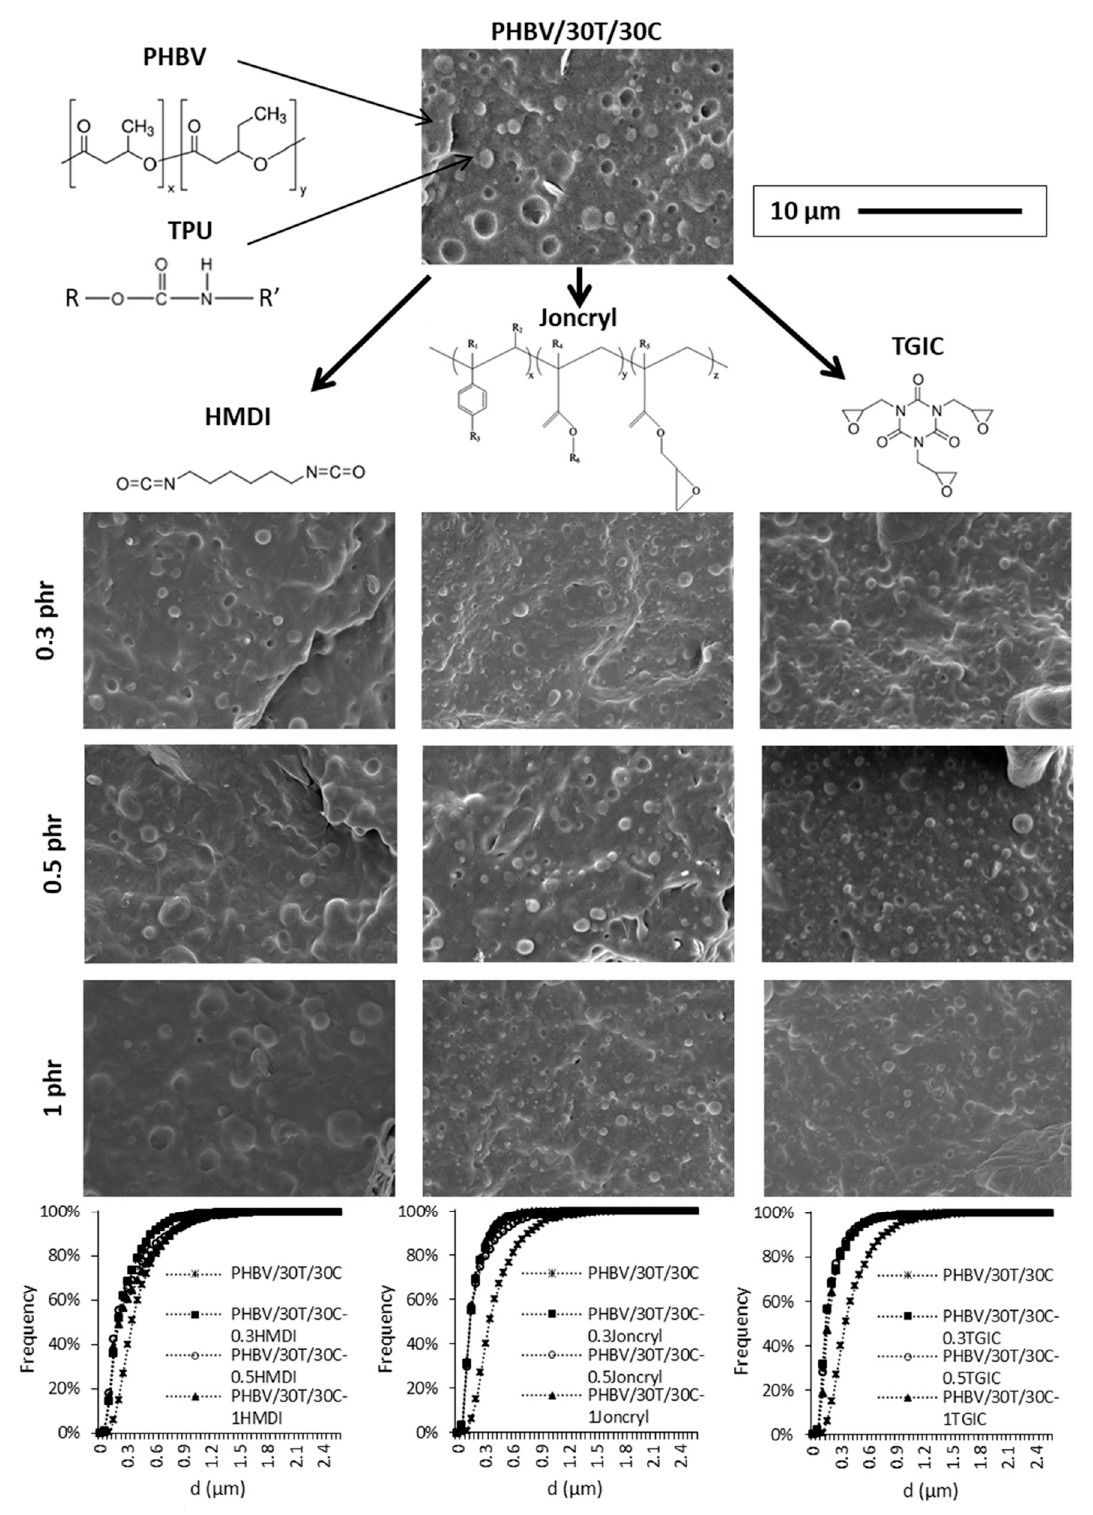
Figure 6. SEM images of the PHBV/30T/30C composites with the different reactive agents and cumulative frequency droplet size histograms of the dispersed phase.